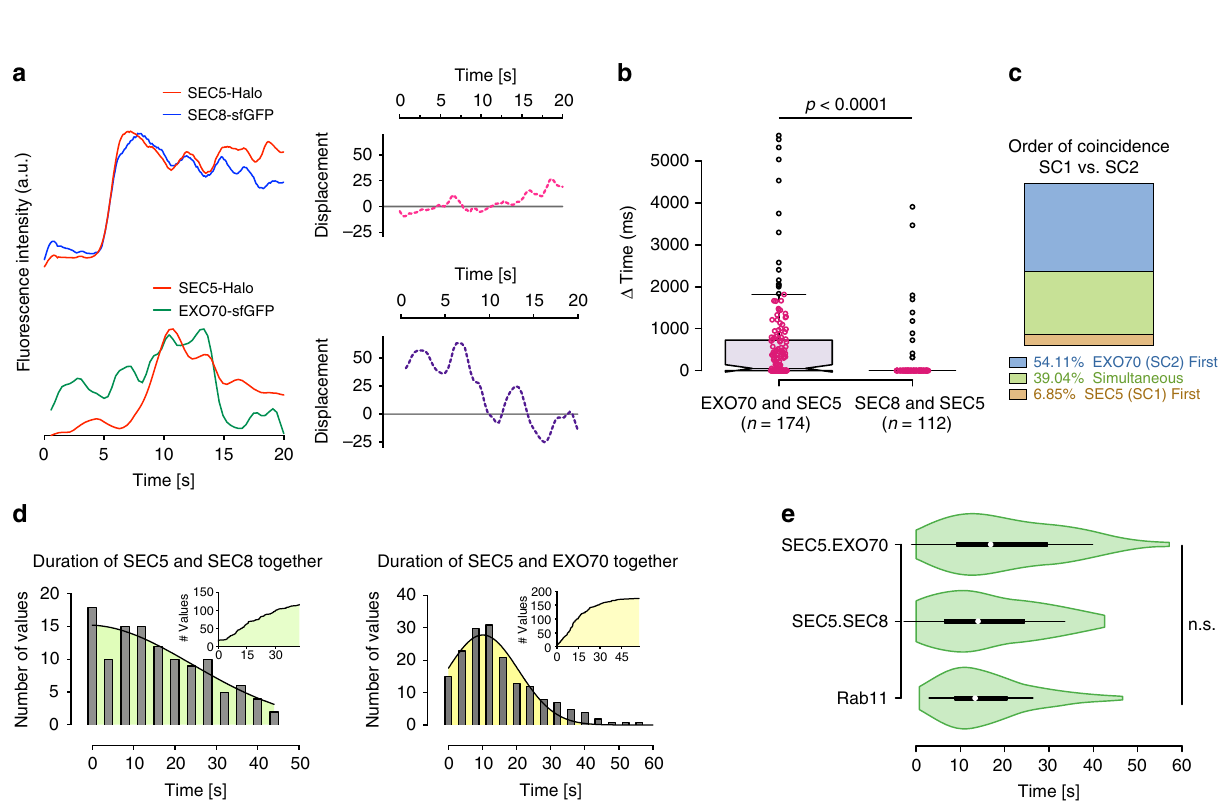
Fig. 4 Coincidence measurements between exocyst subunit pairs by TIRF in live cells. a Fluorescence intensity trajectories (intensity values were normalized to a common scale) for the SEC5-Halo + JF585/SEC8-GFP pair, and SEC5-Halo + JF585/EXO70-GFP pair over 20 s. The fl uorophores were excited simultaneously and images were captured at 12.5 Hz (left). (Right) Graphs show the displacement of the normalized intensities of the two fl uorophores at each time point. b Quanti fi cation of the delay in coincidence between EXO70-GFP and SEC5-Halo + JF585 or SEC8-GFP and SEC5-Halo, measured by TIRFM. Outliers are represented by black circles; data points are plotted as magenta circles. The n denotes number of particles analyzed from a total of three experiments. c Distribution of the order of arrival of EXO70-GFP and SEC5-HaloJF585 shown in panels a and b . d Distributions of the duration of the indicated subunits were together in the TIRF fi eld. e Comparison on the distribution of residence times of Rab11 and the indicated pairs of exocyst subunits. White circles = medians; box limits indicate the 25th − 75th percentiles; whiskers extend 1.5X the interquartile ranges from 25th to 75th percentiles; polygons represent density estimates of data and extend to extreme values. Statistical signi fi cance measured by Kruskal – Wallis test